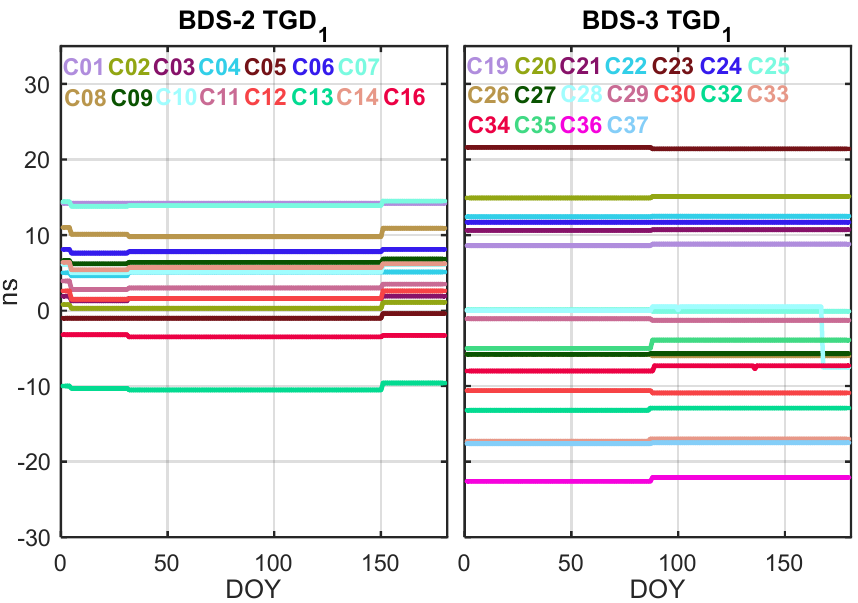
Figure 1. TGD 1 variation of BDS-2 ( left ), (C01–C16), and BDS-3 ( right ), (C19–C37), from Day of Year (DOY) 001 to 180 in 2019.